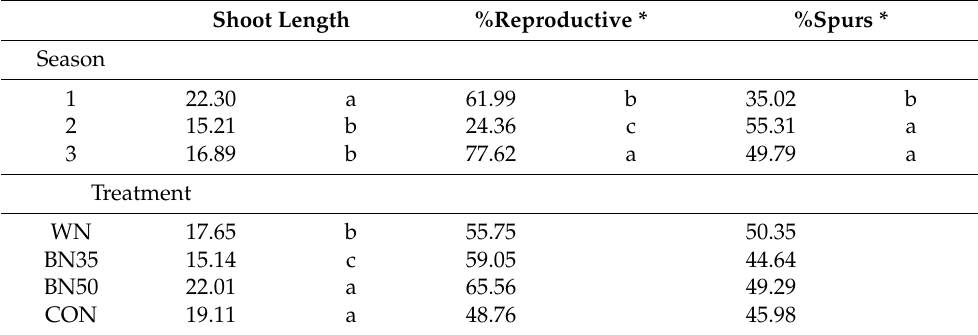
Table 2. Effect of season (1, 2 and 3) and treatments (BN35 = Black net 35, BN50 = Black net 50, WN = White net and CON = control) on shoot length, percentage of reproductive structures (%reproductive), and percentage of short internode structures (%spurs) at next sprouting. Shoot Length %Reproductive * %Spurs * Season 1